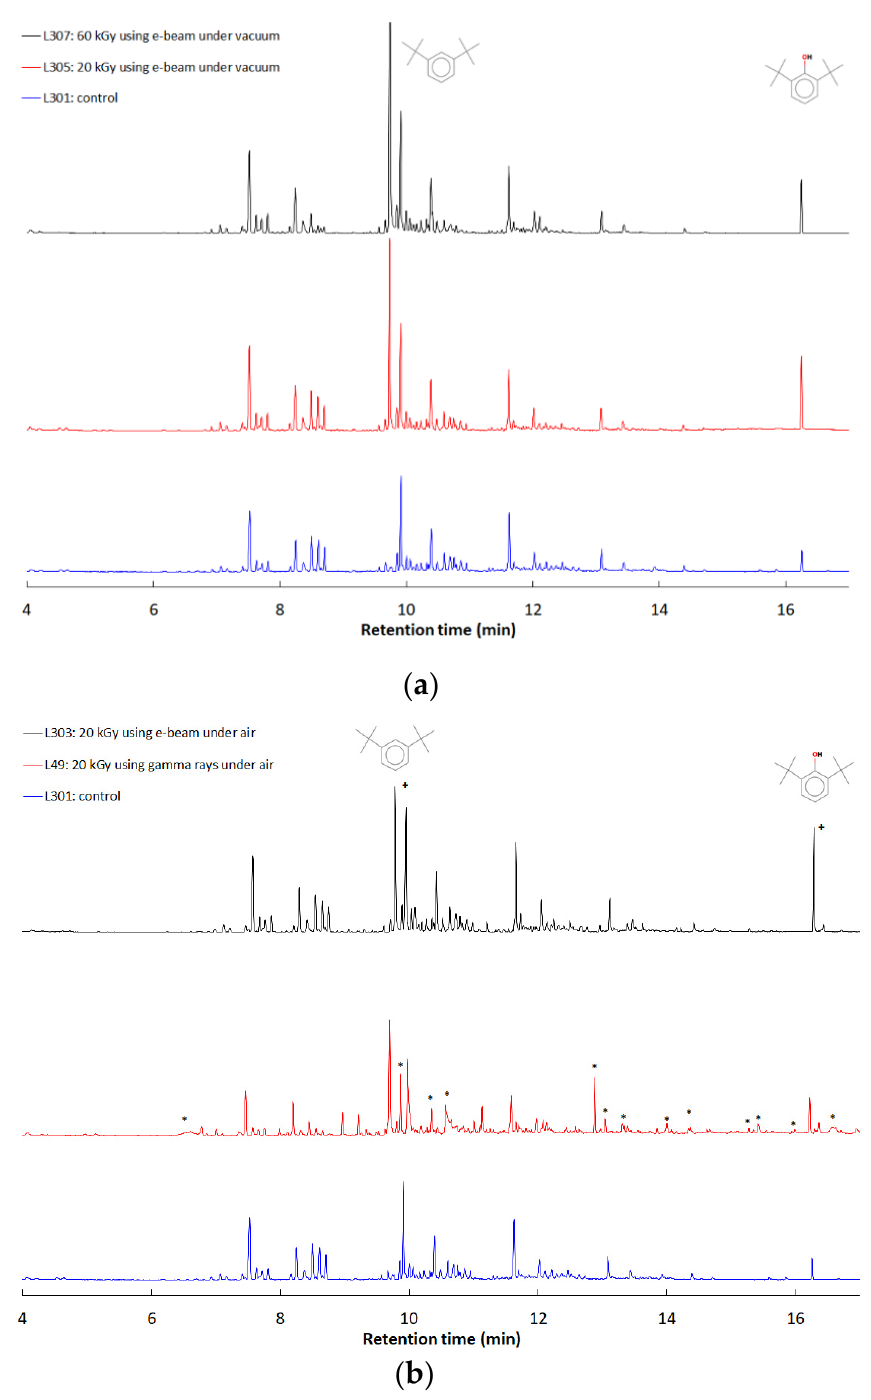
Figure 5. TD-GC-MS chromatograms of all four layers of the Valmy FFP2 mask under different conditions: ( a ) irradiated using e-beam under vacuum and ( b ) irradiated under air using an e-beam and under γ -rays.